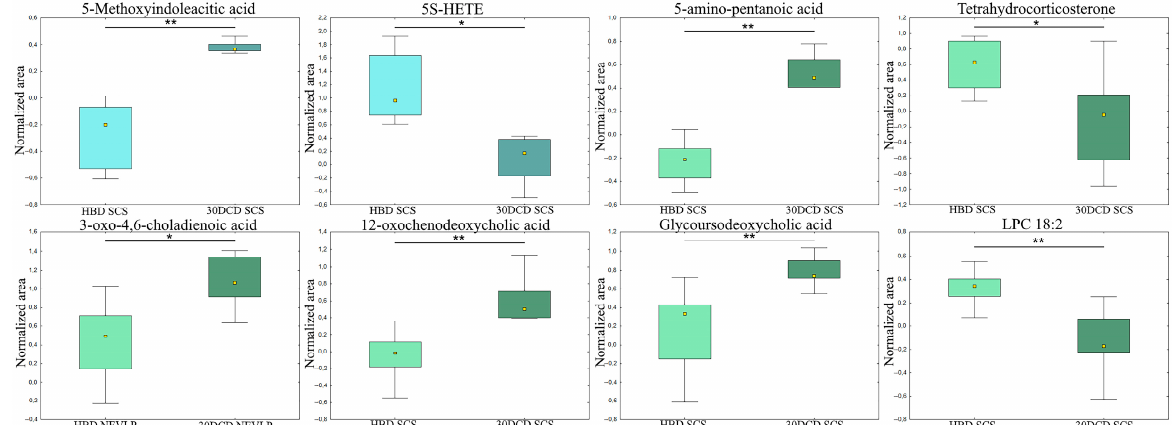
Figure 3. Selected metabolites differentiating the HBD and 30 (cid:48) DCD groups. The boxplots display the normalized peak areas, while the height of the rectangle represents the peak areas in the interquartile range (Q1 and Q3). The upper whisker denotes the largest data point excluding any outliers, and the lower whisker indicates the lowest data point excluding any outliers. The median normalized peak area of each group is indicated with a yellow square. *— p < 0.05; **— p < 0.01; blue = baseline; green = reperfusion.